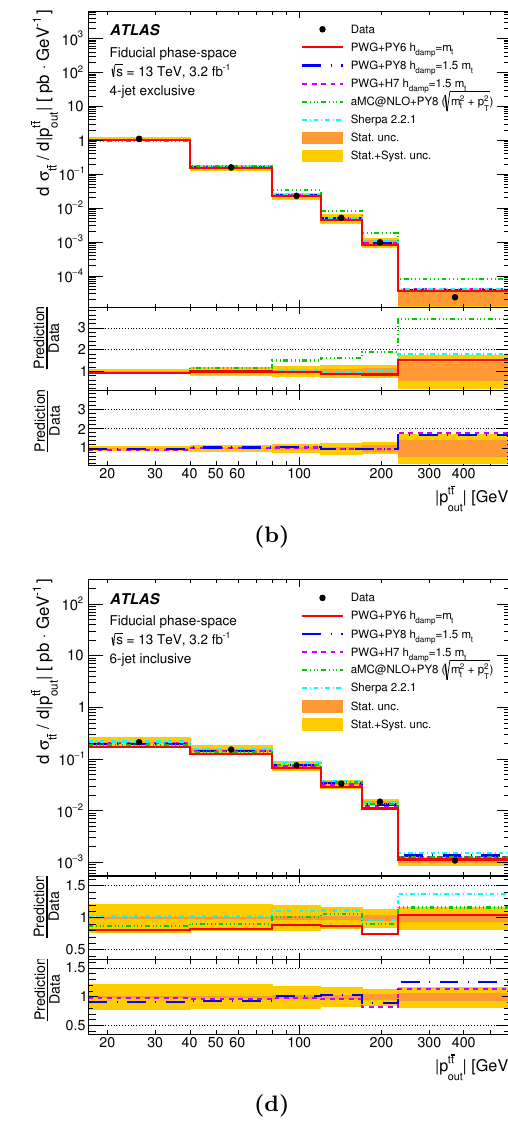
(cid:12) (cid:12) (cid:12) (cid:12) p t (cid:22) t : nor- out (cid:12) (cid:12)